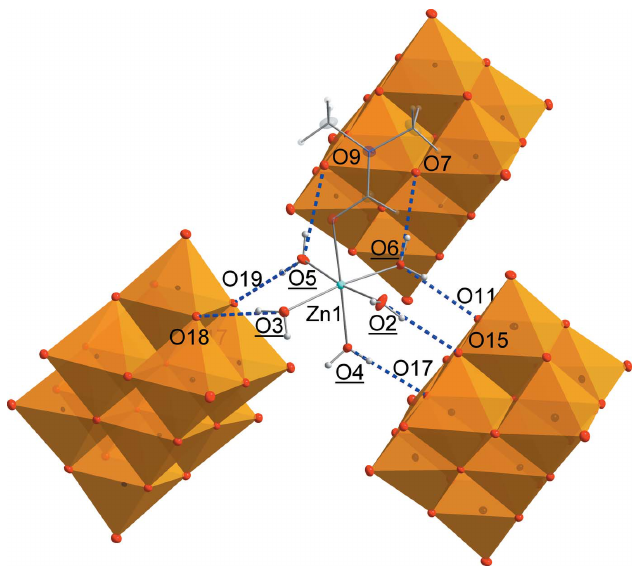
Figure 2 Relative positions of the three adjacent decavanadate anions (orange polyhedra) linked by a single [Zn(H 2 O) 5 (DMF)] 2+